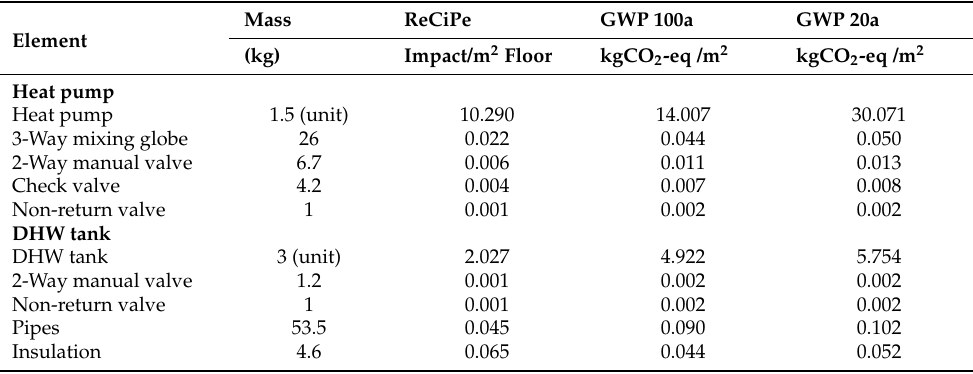
Table 7. LCIA of the reference system during manufacturing/disposal